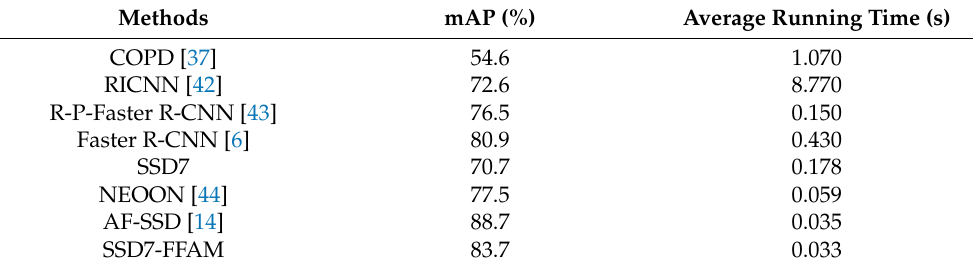
Table 1. The comparison result of the proposed SSD7-FFAM and state-of-the-art methods on the NWPU VHR-10